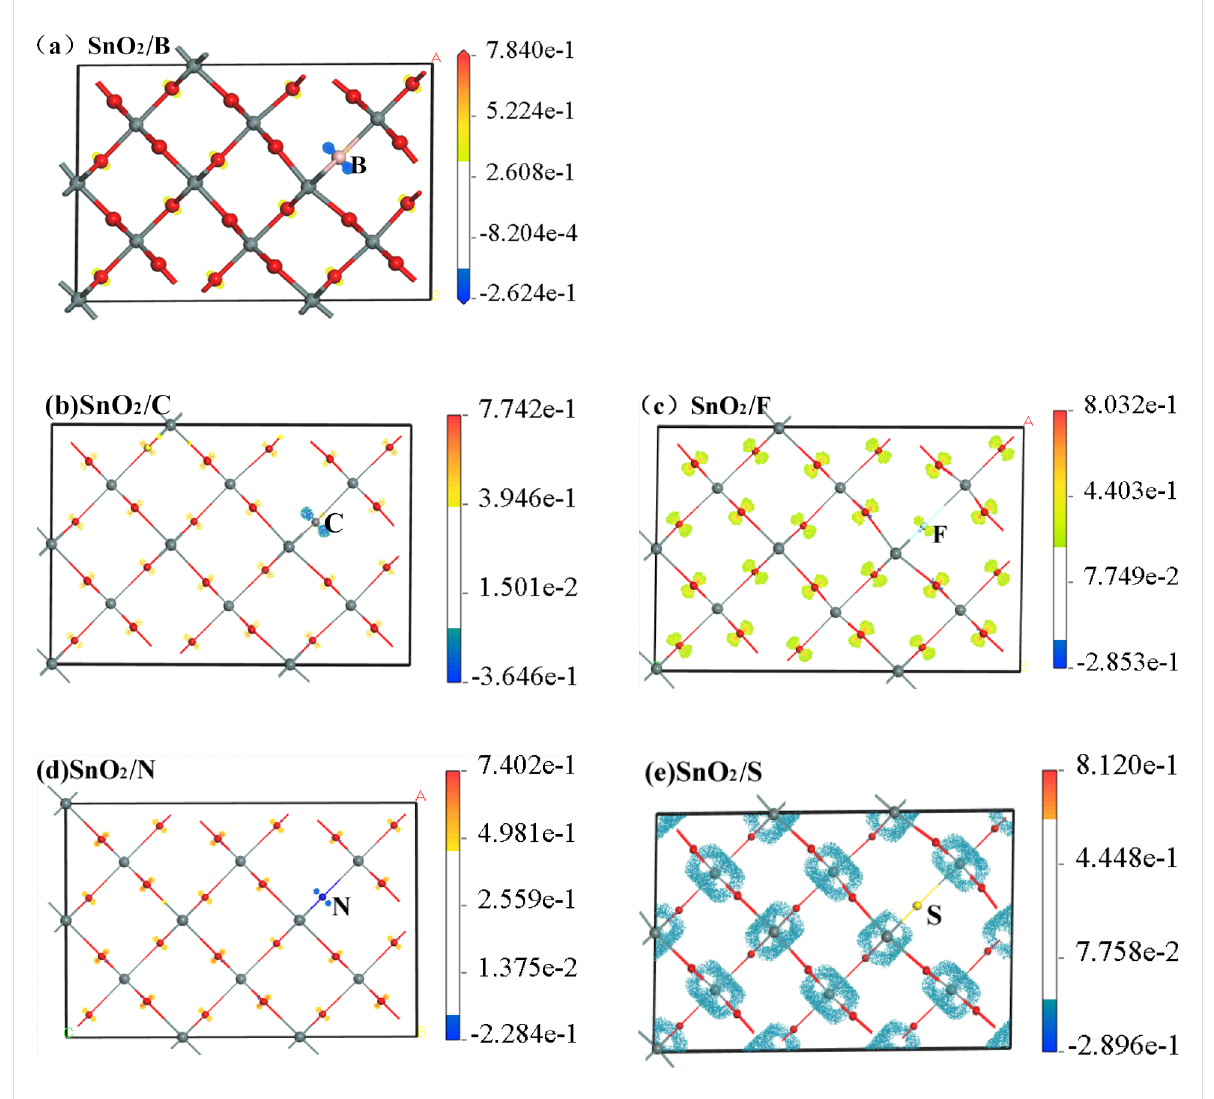
Figure 3: Differential charge density of SnO 2 with O atom substituted by non-metal element.